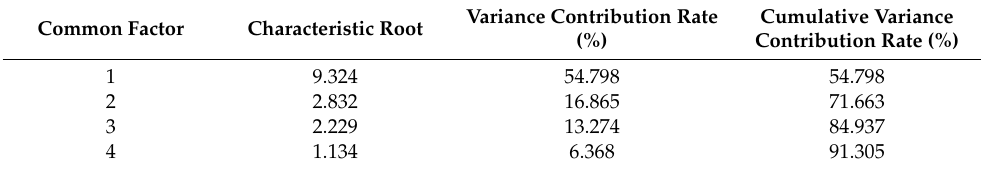
Table 4. Eigenvalue and variance contribution rate.